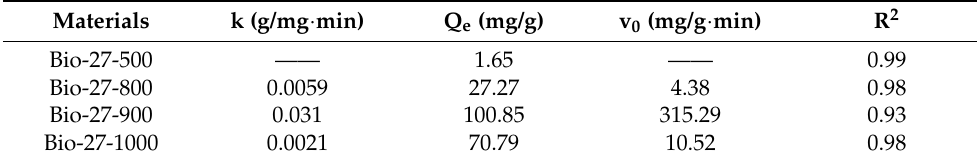
Table 3. Pseudo-second-order adsorption kinetics fitting